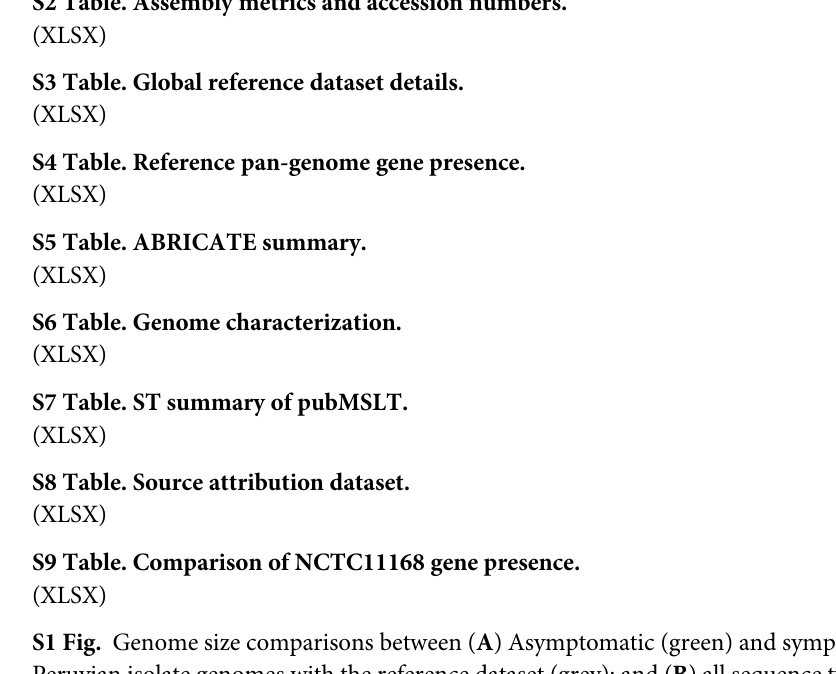
S2 Table. Assembly metrics and accession numbers. S3 Table. Global reference dataset details. S4 Table. Reference pan-genome gene presence. S5 Table. ABRICATE summary. S6 Table. Genome characterization. S7 Table. ST summary of pubMSLT. S8 Table. Source attribution dataset. S9 Table. Comparison of NCTC11168 gene presence. S1 Fig. Genome size comparisons between ( A ) Asymptomatic (green) and symptomatic (red) Peruvian isolate genomes with the reference dataset (grey); and ( B ) all sequence types (ST) represented by 3 or more genomes in the dataset. Dotted line indicates the average genome size for all isolates in the dataset (1,646,868 bp). ( C ) Relative presence of all NCTC 11168 genes (n = 1,623) in the Peruvian and reference datasets. Genes core and accessory in the reference dataset are indicated by (x) and (o), respectively. Genes present more often in one dataset com- pared to the other appear further from the mid-line. ( D ) Pairwise core and accessory genome distances were compared using PopPunk for the Peruvian genomes and full dataset (version SNE) projection of accessory distances in microreact. S2 Fig. Number of ( A ) antimicrobial resistance genes (ARGs), ( B ) virulence genes and ( C ) pre- dicted plasmids per isolate estimated using ABRICATE (version 0.9.8; [69]). ( D ) Maximum- likelihood phylogeny of the Peruvian isolates only. The tree is annotated with disease severity scores, the onset of specific symptoms (hematochezia and fever), presence of AMR genes (beta- lactams, tetracyclines or aminoglycosides), identified plasmids and sialylation prediction. S3 Fig. Average disease severity score by ( A ) isolate host ecology and ( B ) sequence type (rep- resented by 3 or more isolates). ( C ) Representative source attribution of Peruvian pediatric iso- lates using the Bayesian clustering algorithm STRUCTURE (version v2.3.4, [71]). Each isolate is represented by a vertical bar colored by the estimated probability that it originated from putative source reservoirs (yellow: chicken; green: ruminant; black: wild bird and grey: other). ( D ) Summary box plots of predicted attribution of 62 Peruvian pediatric isolates following 5 independent